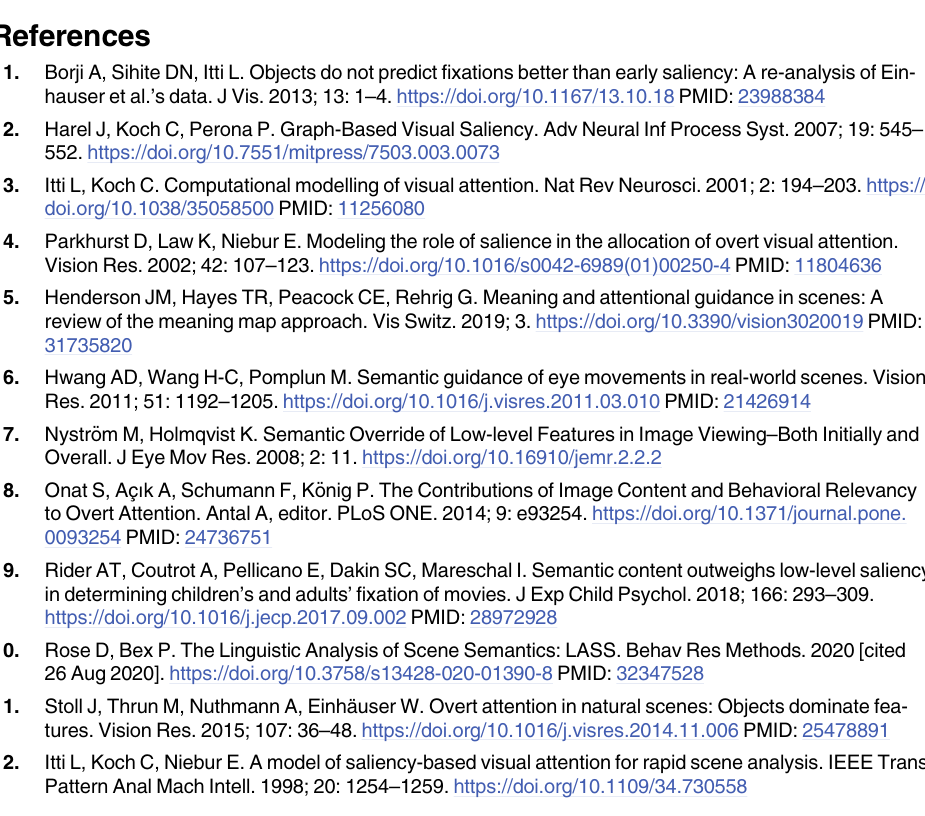
S1 Table. List of all manually edited object labels from the LabelMe database. (XLSX) S2 Table. Top 5 scene labels obtained from PlacesCNN for each image.